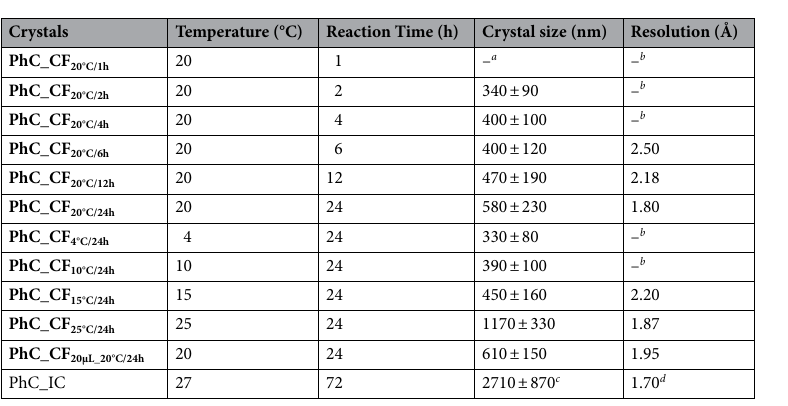
Table 1. Crystal size and Crystallographic data of PhC_CF . a No crystals observed by SEM. b No data sets were obtained. c Supplementary Fig. 2. d Reference 28